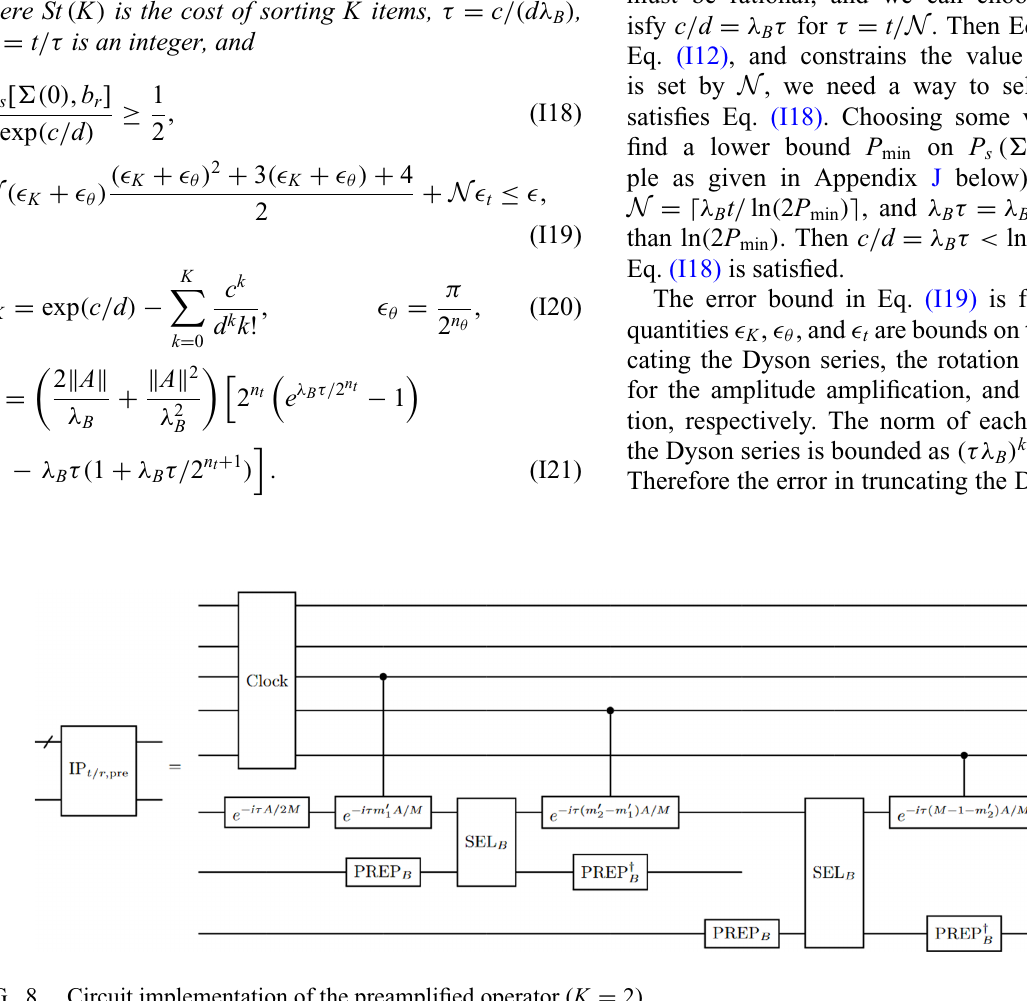
FIG. 8. Circuit implementation of the preamplified operator ( K =